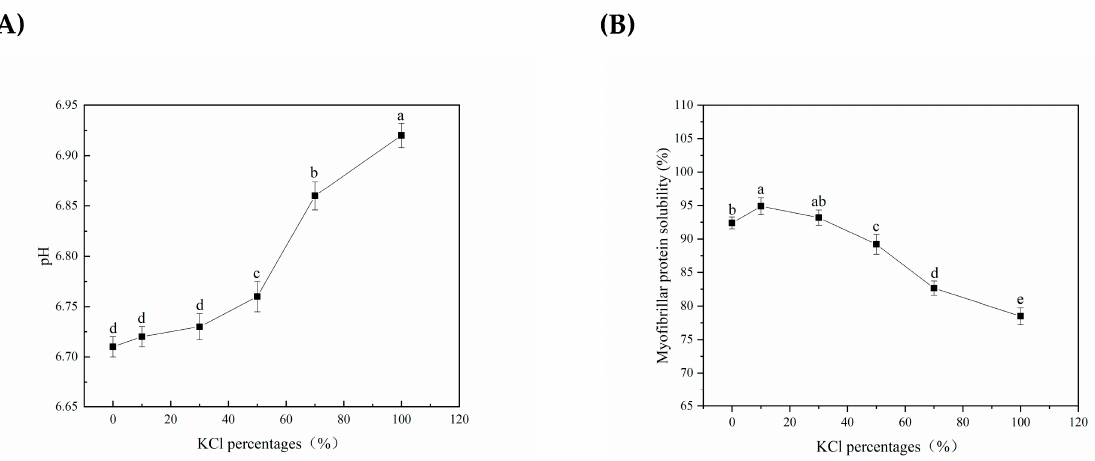
Figure 1. Change in pH and myofibrillar protein solubility of salted tilapia fillets as affected by different KCl replacements. ( A ) pH; ( B ) myofibrillar protein solubility. Values with different lowercase letters are significantly different at p <